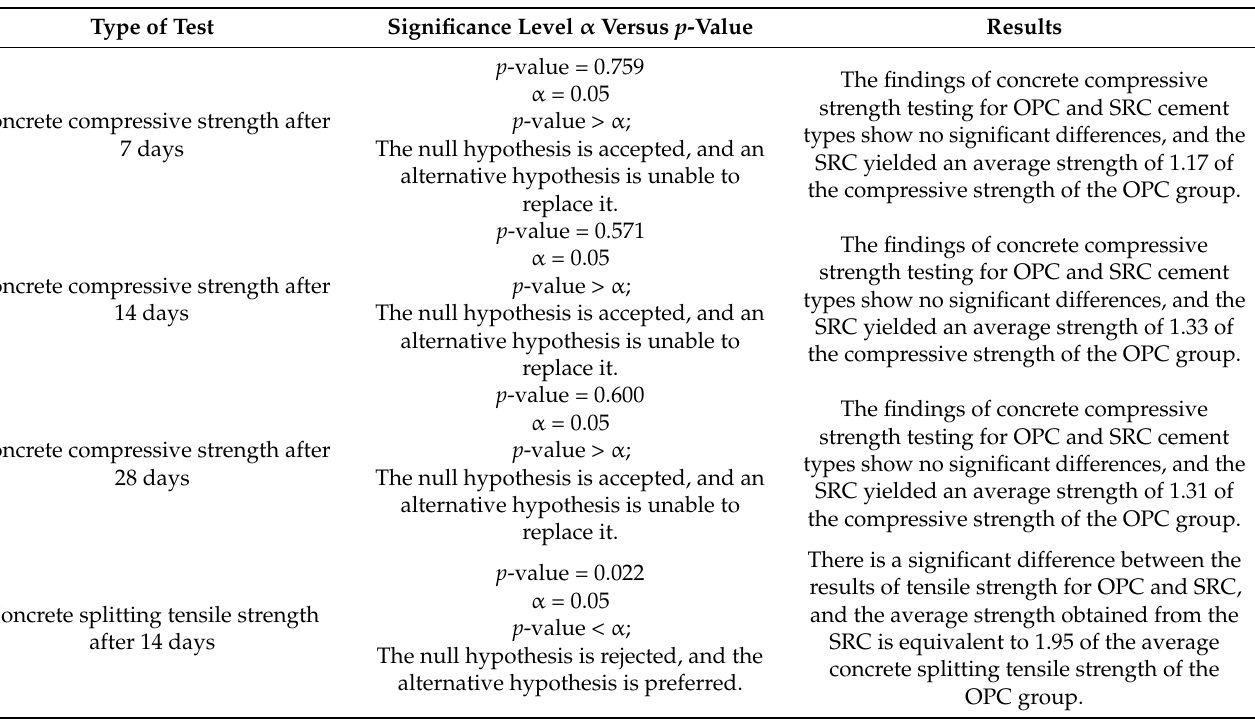
Table 16. Results and conclusion of the independent t